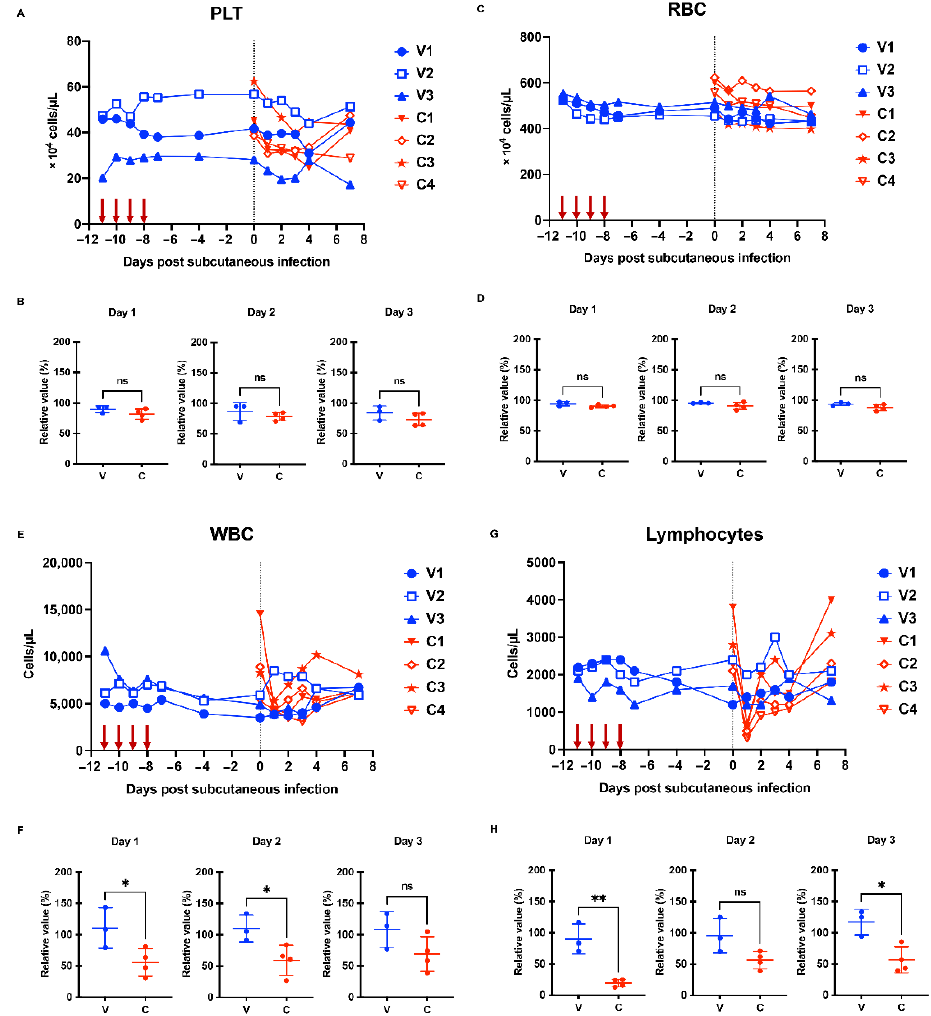
Figure 3. Changes in blood parameters in ZIKV-infected monkeys. ( A ) The number of platelets was counted with a hematology analyzer. While V1-V3 denotes each animal ID in group V (intravaginal pre-inoculation), C1-C4 denotes one in group C (control). ( B ) The relative value of platelets on Days 1, 2, and 3 was calculated compared to Day 0. Differences between groups V and C were examined by a two-tailed, unpaired Student t -test (ns, not significant). ( C ) The number of red blood cells (RBC) was counted with a hematology analyzer. ( D ) The relative value of red blood cells (RBC) on Days 1, 2, and 3 was calculated compared to Day 0. Differences between groups V and C were examined by a two-tailed, unpaired Student t -test (ns, not significant). ( E ) The number of white blood cells (WBC) was counted with a hematology analyzer. ( F ) The relative value of WBC on Days 1, 2, and 3 was calculated compared to Day 0. Differences between groups V and C were examined by a two-tailed, unpaired Student t -test. * p < 0.05, ns (not significant). ( G ) The number of lymphocytes was counted with a hematology analyzer. ( H ) The relative value of lymphocytes on Days 1, 2, and 3 was calculated compared to Day 0. Differences between groups V and C were examined by a two-tailed, unpaired Student t -test. ** p < 0.01, * p < 0.05, ns (not significant). ZIKV, Zika virus.